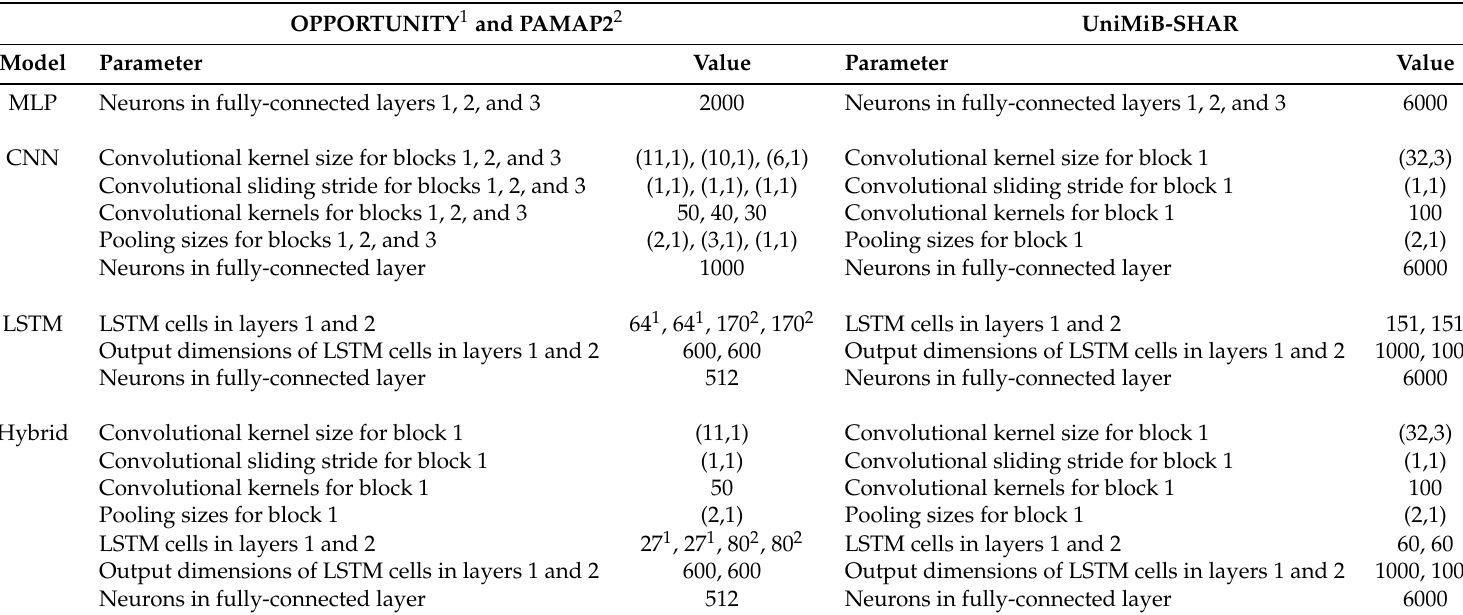
Table 1. Settings of the models used on the OPPORTUNITY, UniMiB-SHAR, and PAMAP2 datasets. 1 and 2 indicate the number of LSTM cells used in the OPPORTUNITY and PAMAP2 datasets,